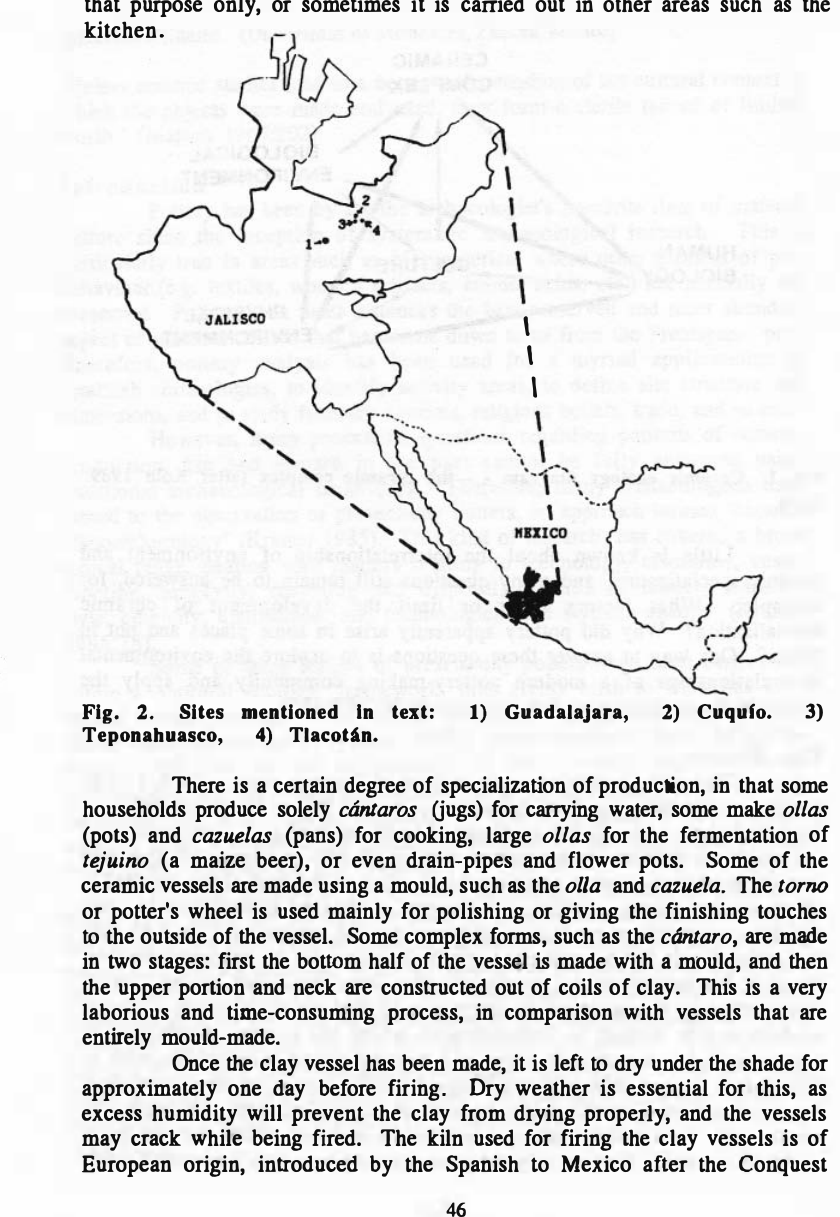
1) Guadalajara, 2) Cuqufo.